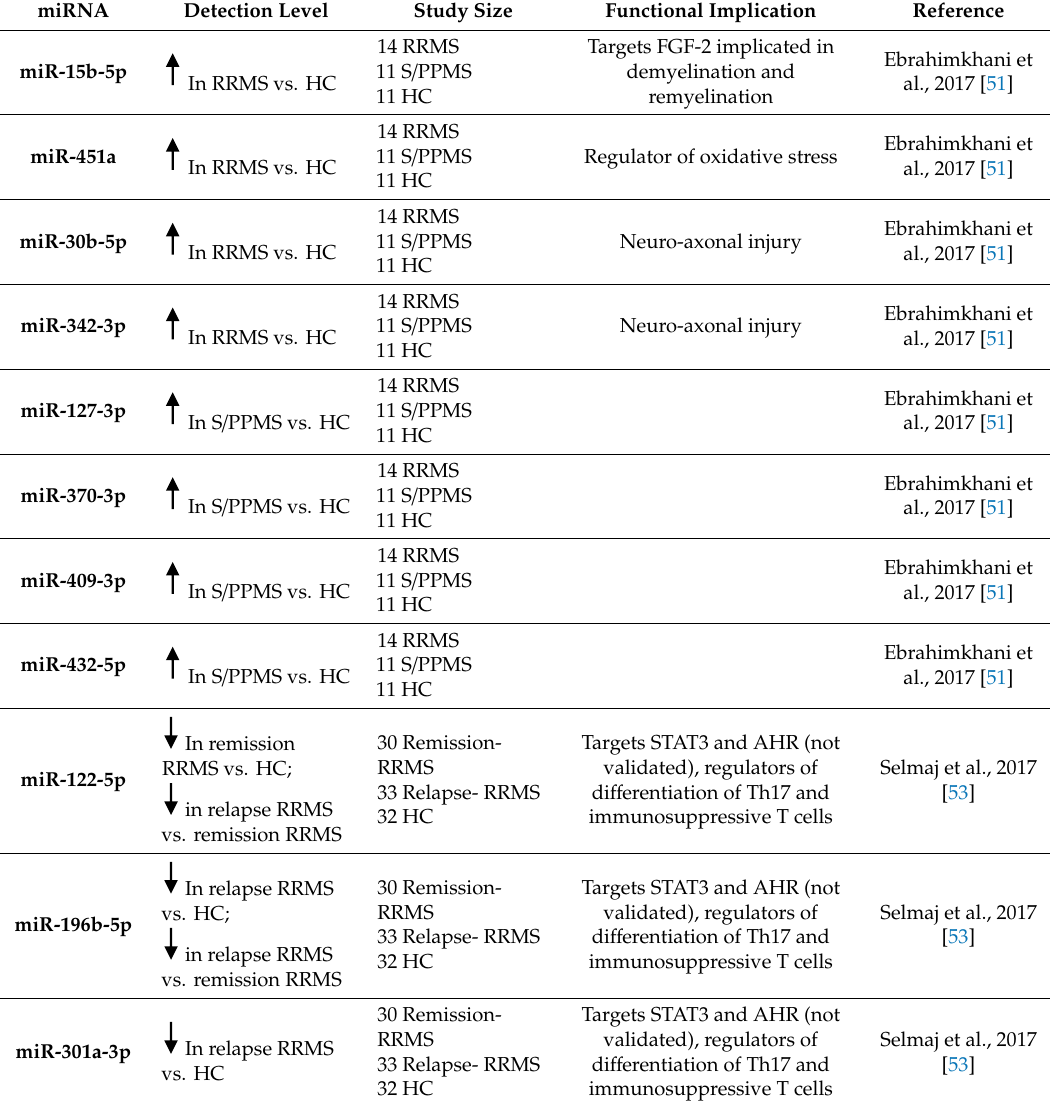
Table 1. Extracellular vesicle (EV) classification and their potential role in multiple sclerosis (MS). Table 2. Classification of miRNA content in EVs involved in MS.